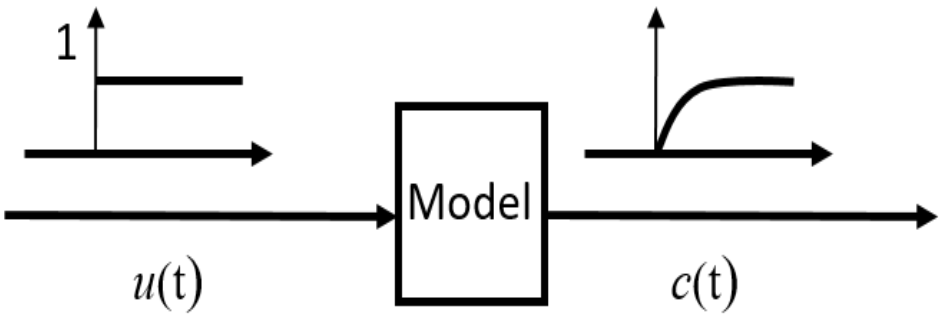
Figure 3. Unit step input and response.